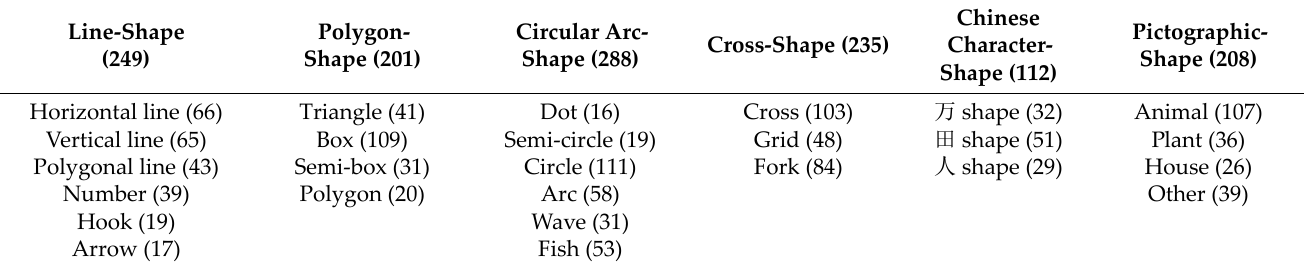
Table 1. Sample image data of pottery scribing